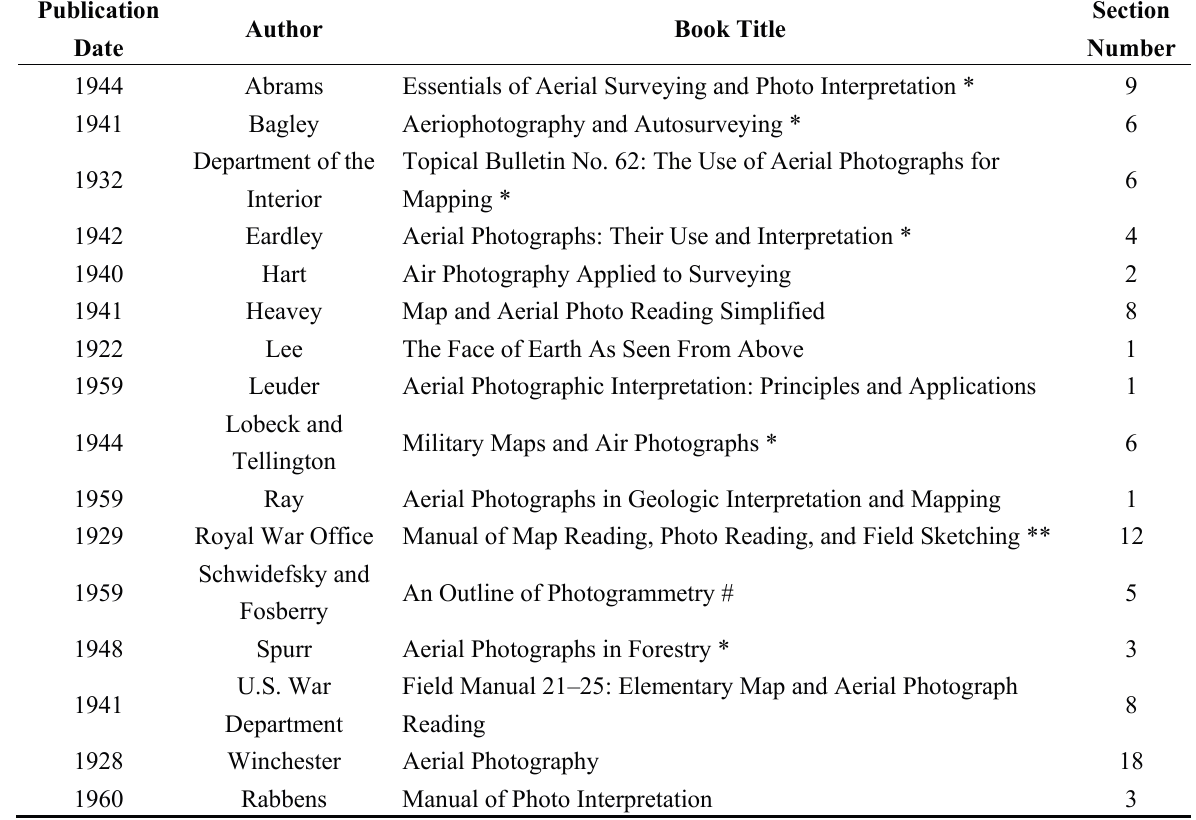
Table 4. Information about the texts used in this analysis. (Text’s publishing origins: United States *, United Kingdom **, Germany